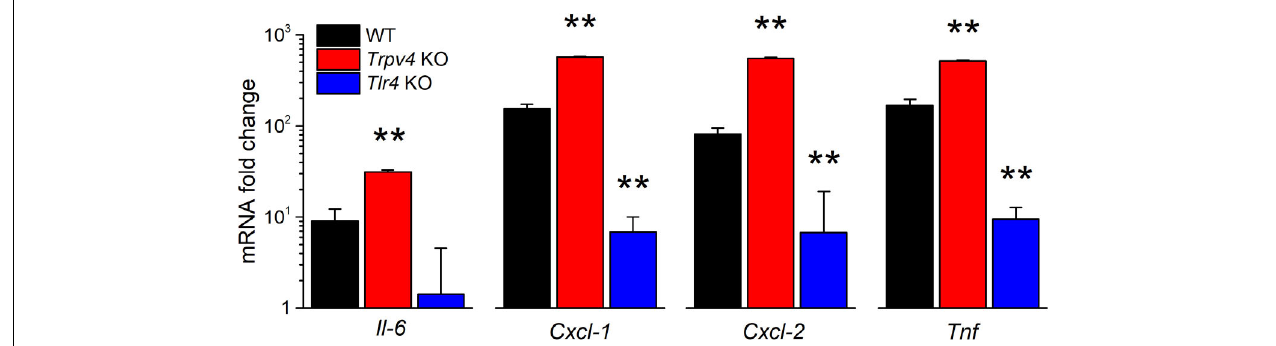
FIGURE 6 | Differential regulation of LPS-induced cytokine gene expression by TRPV4 and TLR4 in mUCs. Fold change of the expression levels of pro-inflammatory genes in urothelial cells derived from WT, Trpv4 KO and Tlr4 KO mice and treated with E. coli LPS (20 µ g/ml, 30 min). The data is presented as mean ± SEM. of the expression levels relative to the respective values obtained in the untreated condition ( n = 3). The ** symbols indicate P < 0.01, with a Tukey’s multiple comparison